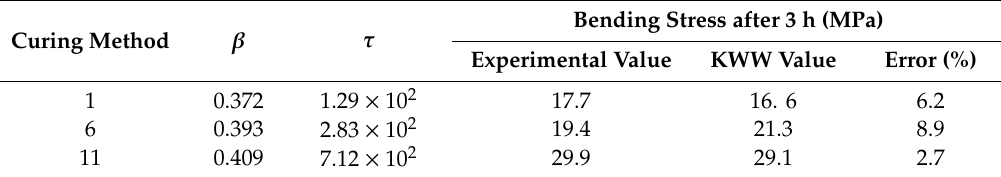
Figure 11. Comparison between the experimental average curve and theoretical curve obtained with the Kohlrausch–Williams–Watts (KWW) model for samples cured by method 1 (bending strain correspondent to 51.5 MPa). Table 3. Parameters of the KWW model for stress